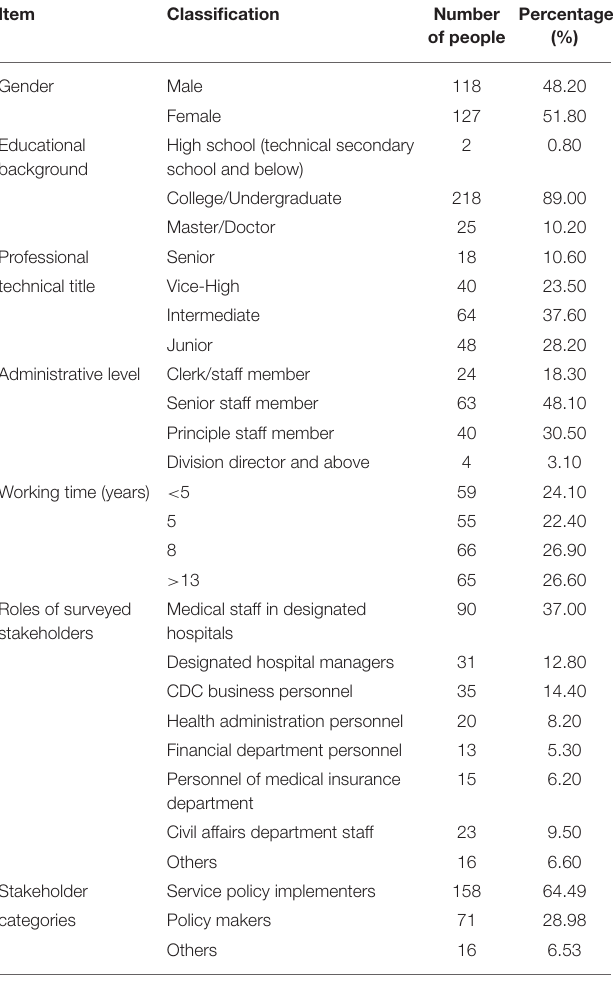
TABLE 3 | Socio-demographic characteristics of the